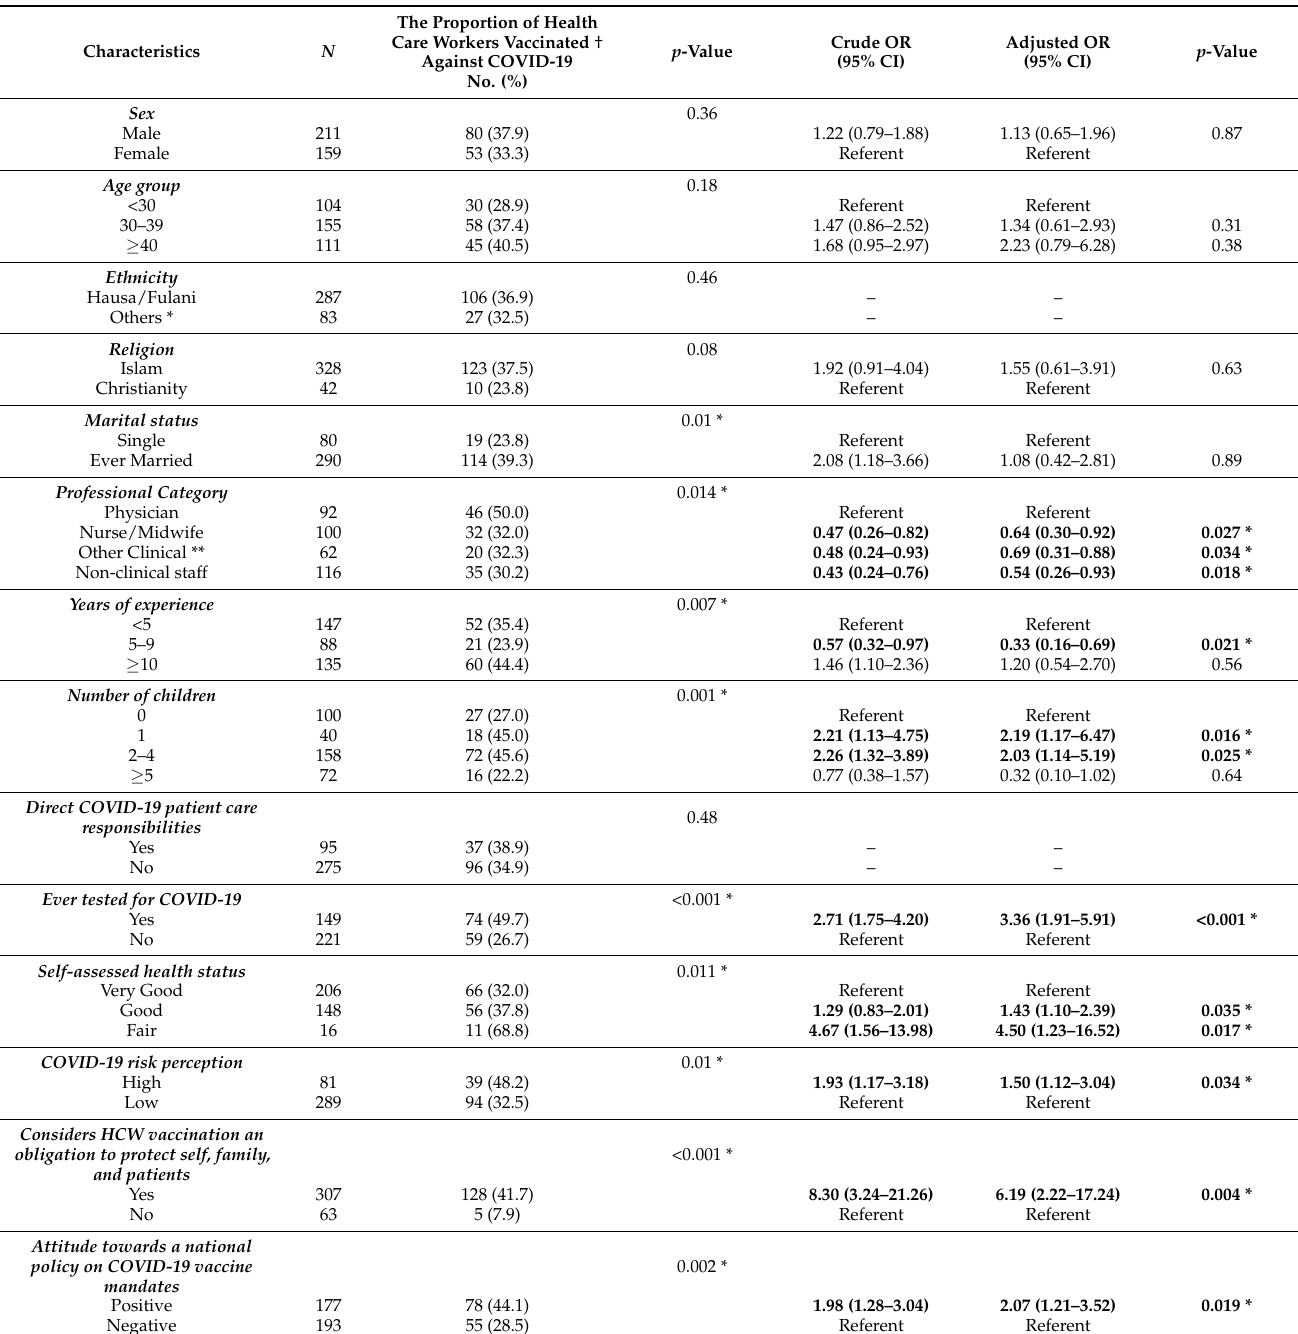
Table 4. Logistic regression model for predictors of health care workers’ COVID-19 vaccination status, Kano, Nigeria ( N =